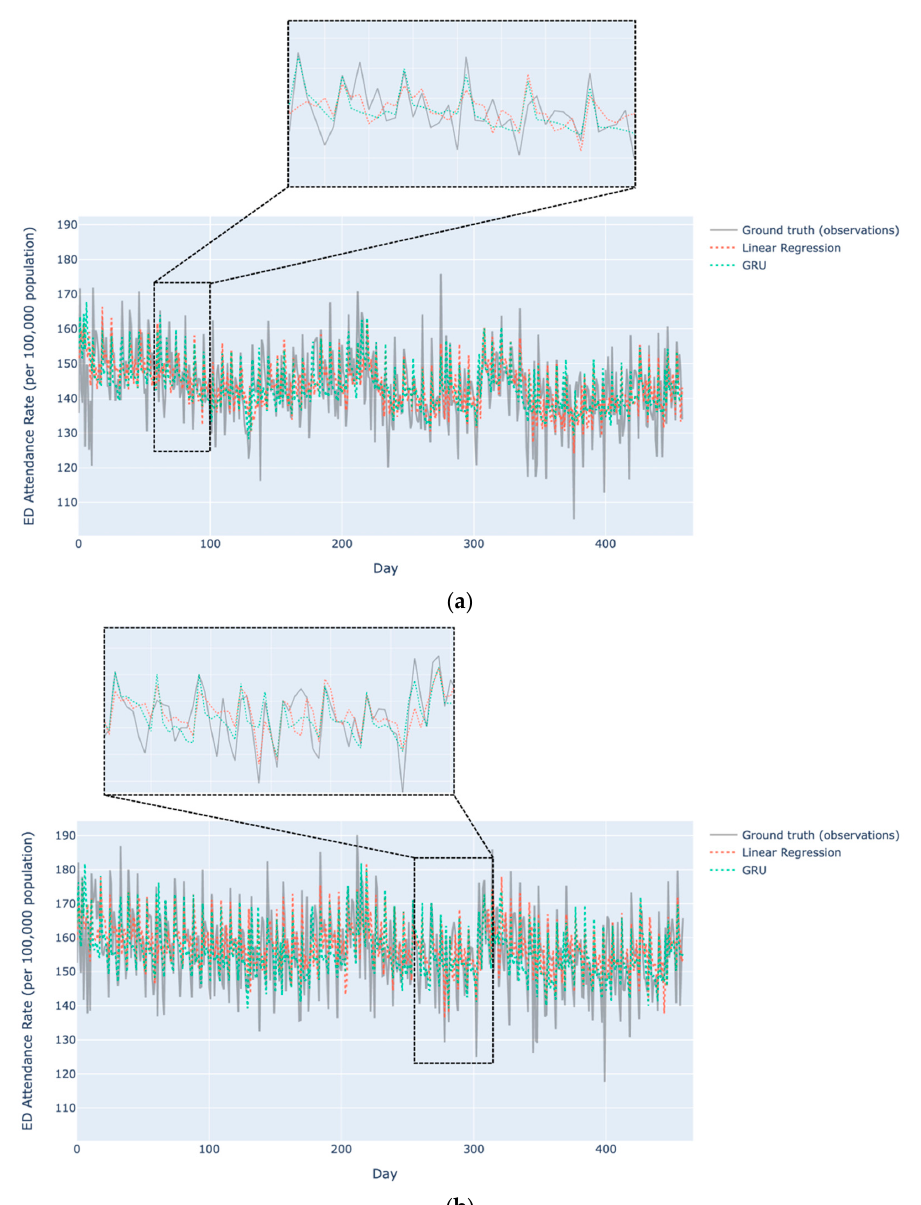
Figure 5. Visualization of ground truth and predictions from linear regression model (baseline) and GRU. ( a ) Female group; ( b ) male group.